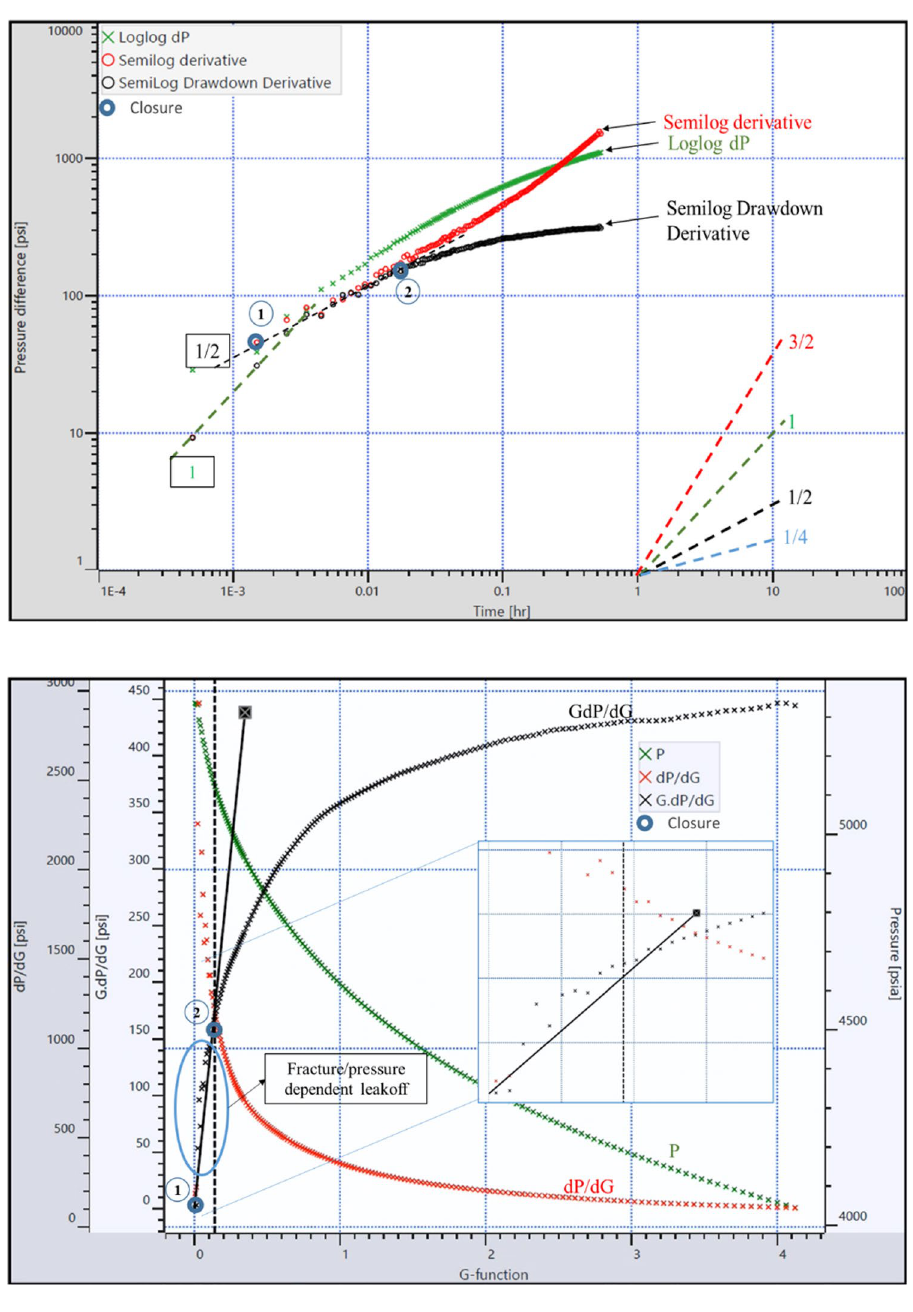
bore storage 1 ) and establishes a ½ slope. The ½ slope in the